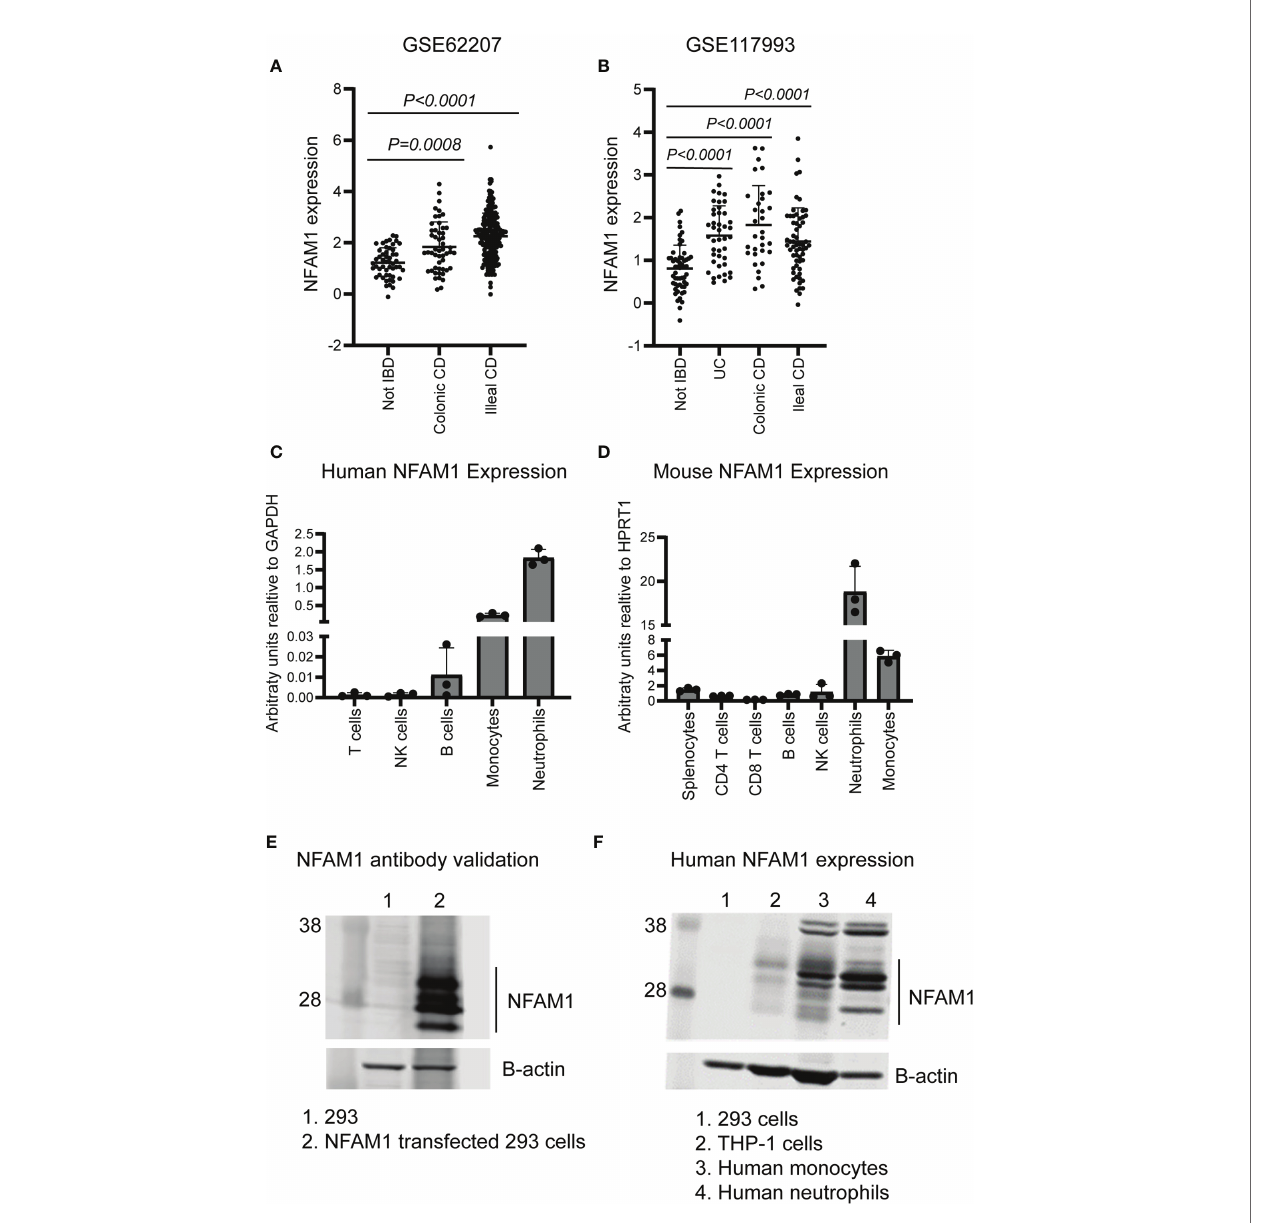
FIGURE 1 | NFAM1 expression is increased in IBD and can be detected in cells of the innate and adaptive immune system. (A, B) NFAM1 mRNA expression in intestinal biopsies from non-IBD controls, colonic CD, ileal CD, or UC (data from publicly available datasets GSE62207 and GSE117993, see methods section for study description). (C) NFAM1 mRNA expression in human T cells, B cells, NK cells, monocytes and neutrophils. Shown is mean expression from three donors. Data is representative of two independent experiments. (D) NFAM1 mRNA expression in mouse splenocytes, CD4 T cells, CD8 T cells, B cells, NK cells, monocytes and neutrophils. Shown is mean expression from three independent mice. Data is representative of two independent experiments. In the second experiment (data not shown), samples were pooled from 10 individual mice. (E) NFAM1 protein expression in 293 cells or 293 cells transfected with NFAM1 cDNA. Results are representative of greater than 5 independent experiments. (F) NFAM1 protein expression in 293 cells, THP-1 cells, human monocytes and human neutrophils. Data is representative of three independent experiments from three independent